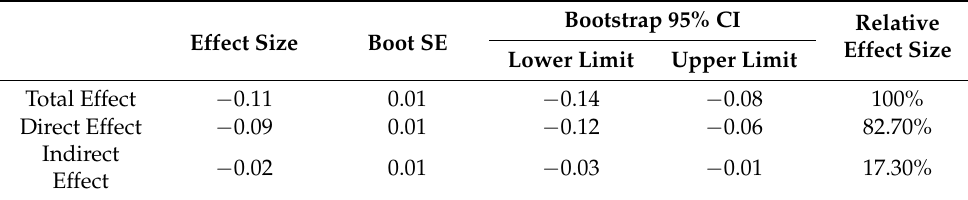
Table 5. Total effect, direct effect, and indirect effect among the variables.